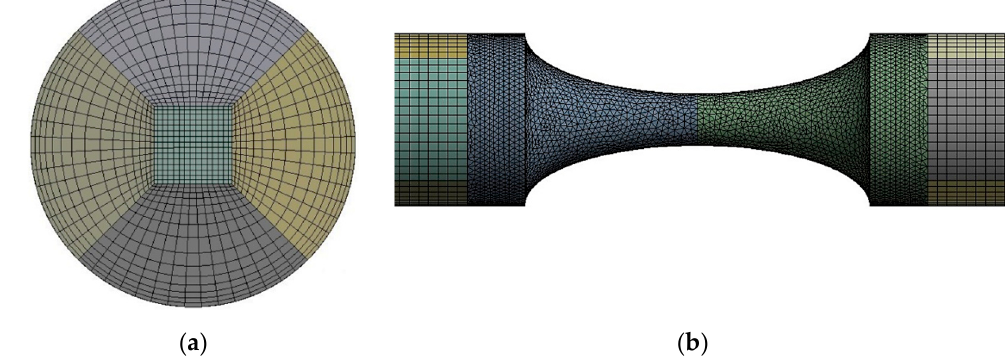
Figure 4. Hybrid mesh generated for the 70% model: ( a ) inlet view; ( b ) front view.